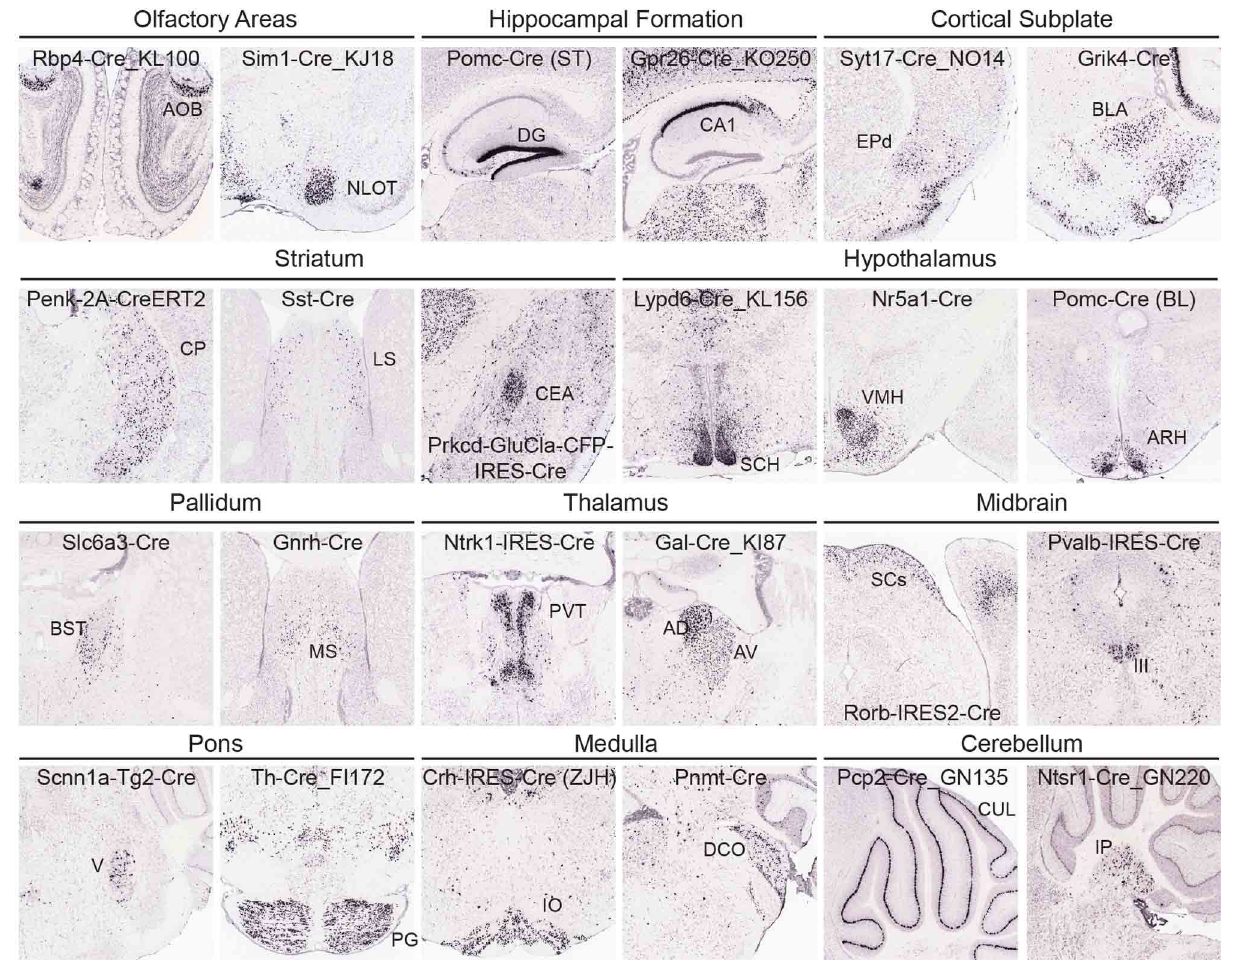
Pnmt-Cre), and cerebellum (Pcp2-Cre_GN135, Ntsr1-Cre_GN220). Abbreviations are: AOB, accessory olfactory bulb; NLOT, nucleus of the lateral olfactory tract; DG, dentate gyrus; field CA1; EPd, endopiriform nucleus, dorsal part; BLA, basolateral amygdalar nucleus; CP, caudoputamen; LS, lateral septal nucleus; CEA, central amygdalar nucleus; SCH, suprachiasmatic nucleus; VMH, ventromedial hypothalamic nucleus; ARH, arcuate nucleus; BST, bed nuclei of the stria terminalis; MS, medial septal nucleus; PVT, paraventricular nucleus of the thalamus; AD, anterodorsal; and AV, anteroventral nucleus of the thalamus; SCs, superior colliculus, sensory related; III, oculomotor nucleus; V, motor nucleus of trigeminal; PG, pontine gray; IO, inferior olivary complex; DCO, dorsal cochlear nucleus; CUL, culmen; and IP, interposed nucleus.